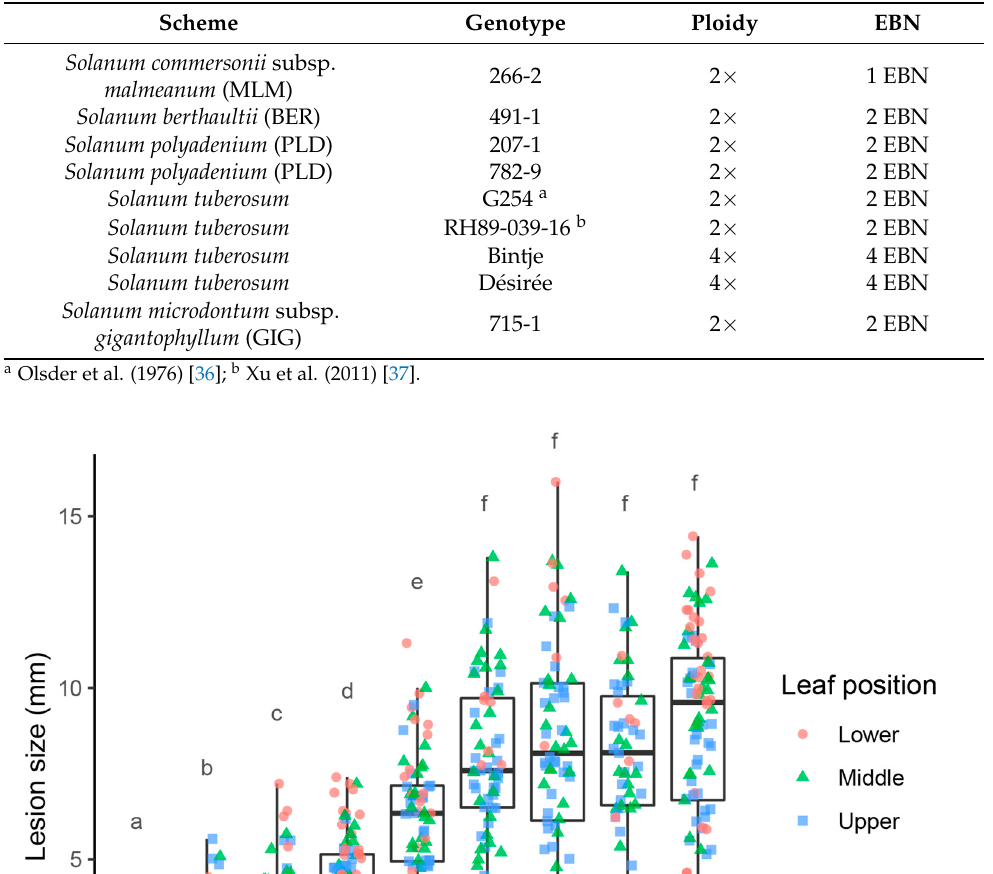
Table 1. Overview of genotypes used in this study. Species, genotype name, ploidy and EBN class of each genotype are listed.